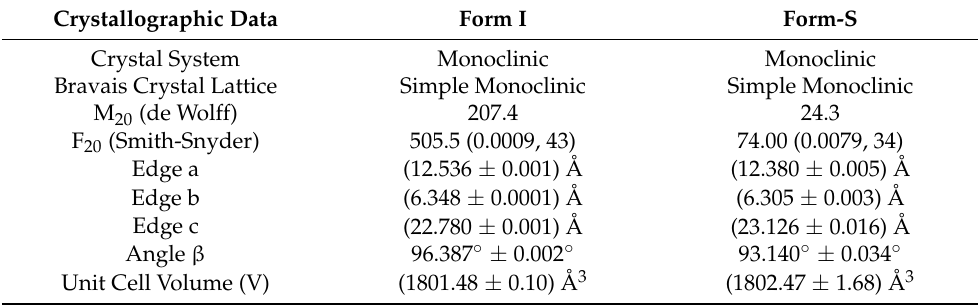
Table 3. Comparison of the crystallographic data of posaconazole Form I and Form-S, as determined via the dichotomy method using PreDICT software, applied on their XRPD patterns. The angles α and γ are 90.0 ◦